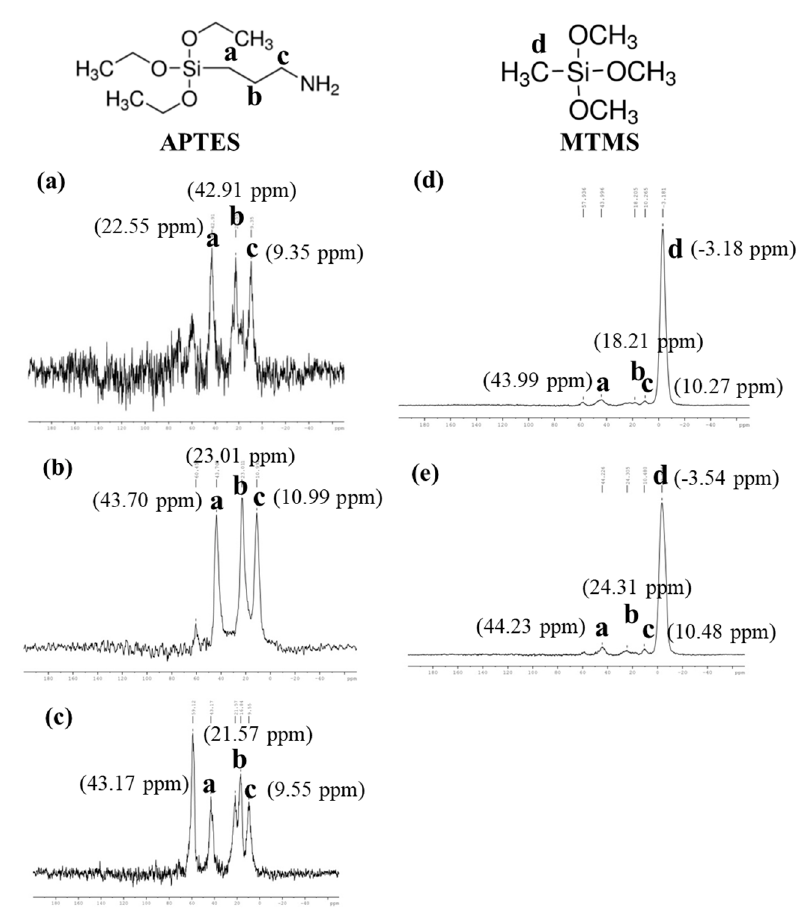
Figure 3. Solid-state 13C-NMR spectra of the hydrophilic ( a ) A1, ( b ) A2, and ( c ) A3 MSPs, as well as the hydrophobic ( d ) M1 and ( e ) M2 MSPs.